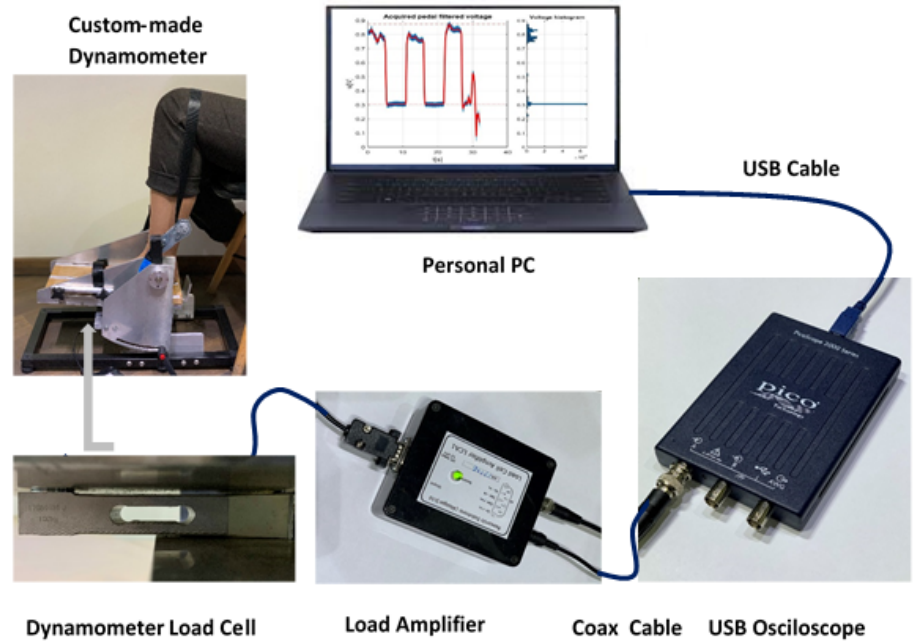
Figure 1. Block diagram components of the used measurement system.